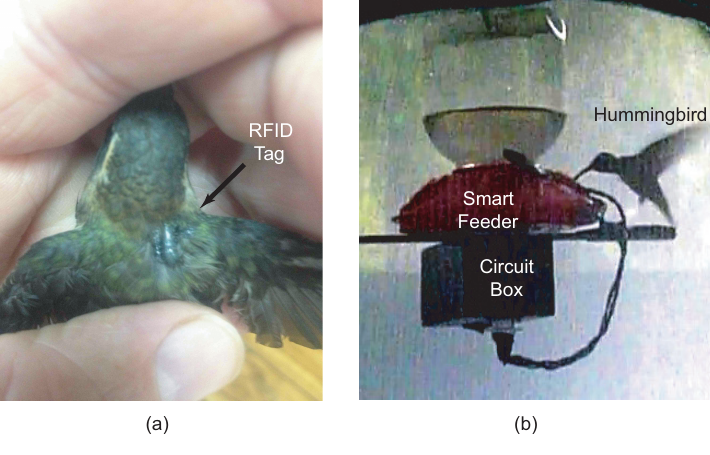
Figure 8. ( a ) PIT tag adhered to hummingbird; ( b ) Hummingbird consuming nectar food from the proposed RFID smart